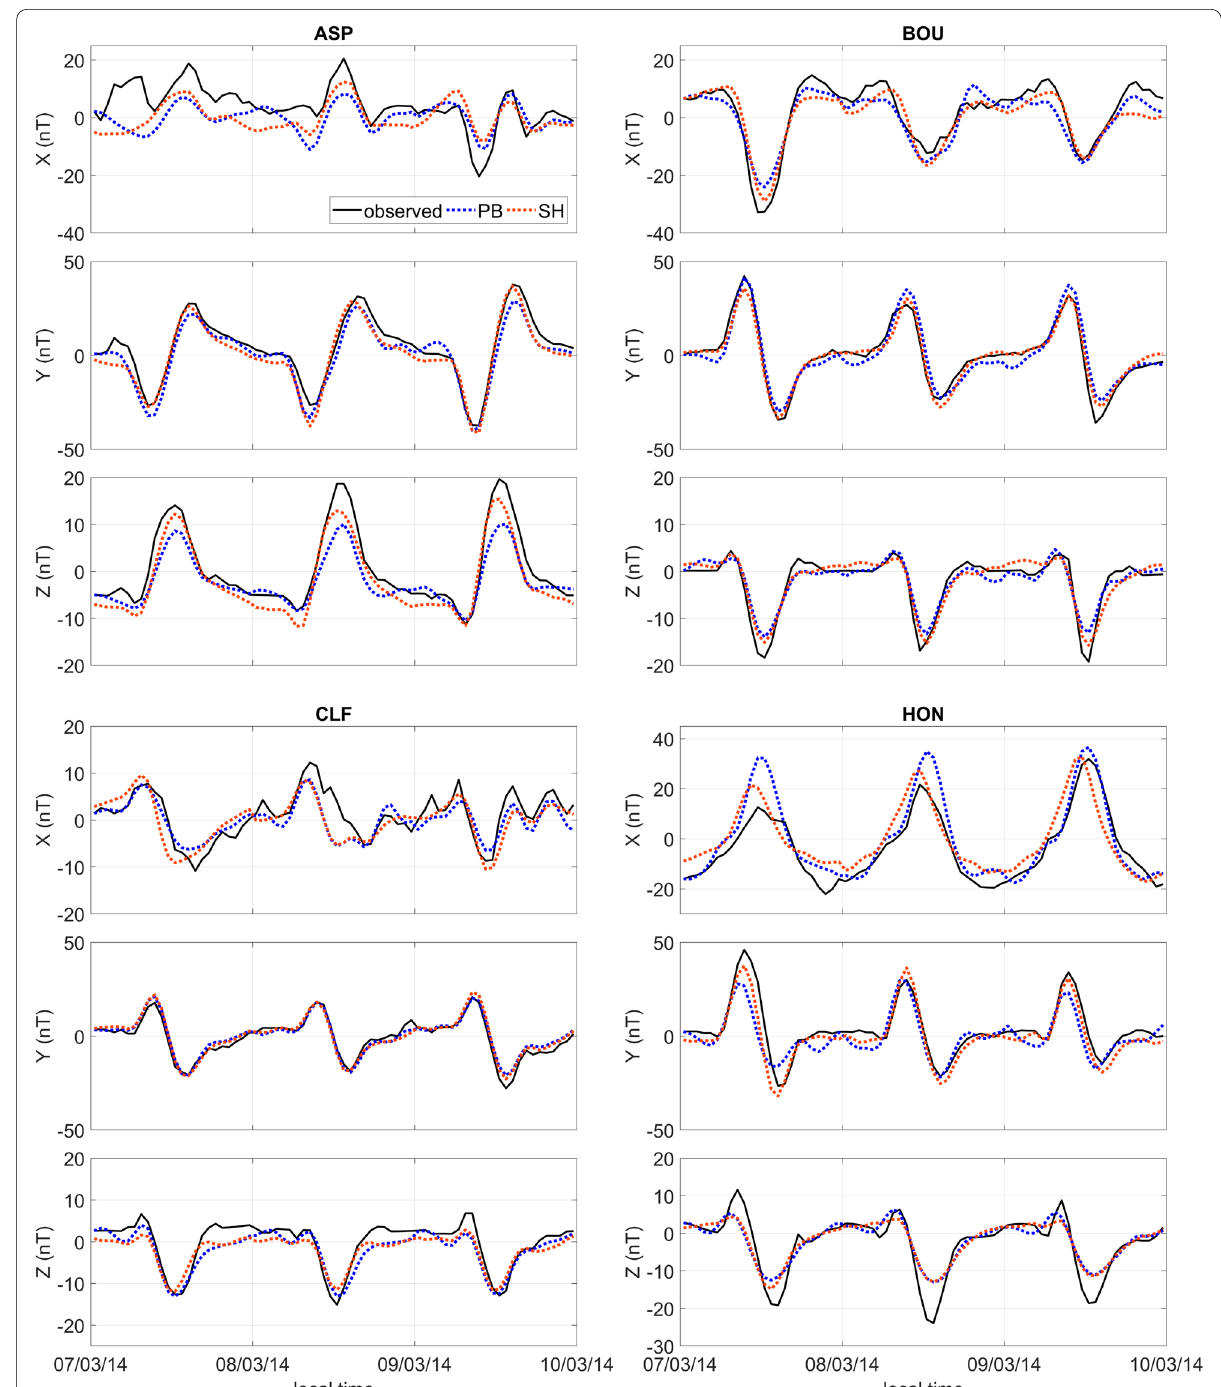
Fig. 11 Comparison of observed (black) and predicted magnetic field components X , Y , and Z . Predictions using the physics-based and SH parameterization are given by the blue and red dashed lines, respectively. Shown are the results for observatories ASP, BOU, CLF, and HON for a period between March 8th and March 14th, 2014. SH results are from Guzavina et al. (2019). Note the different y -axis